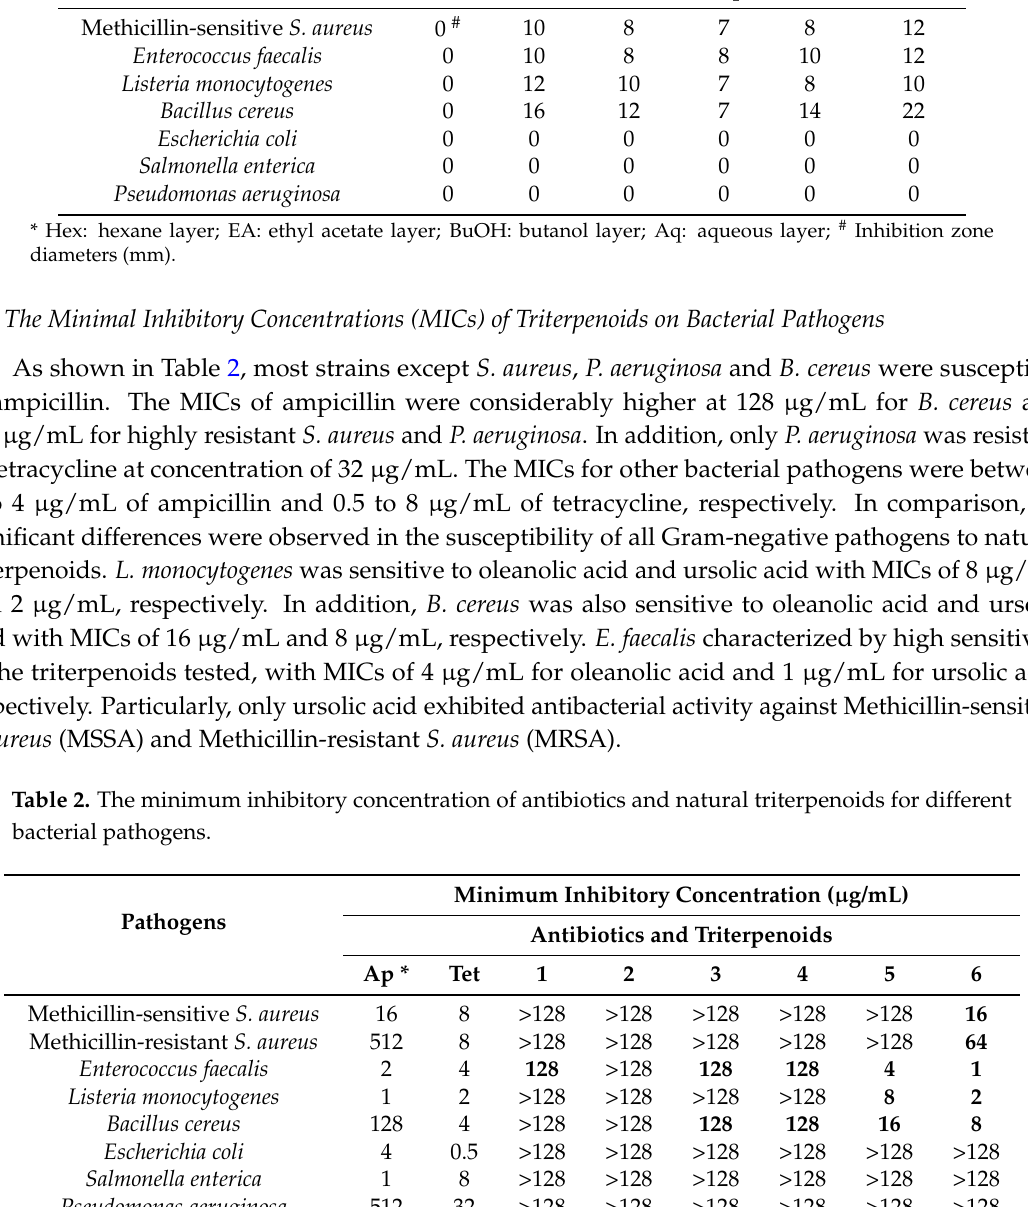
Table 1. Antibacterial activities of chemical fractions from the leaf extract of A. scholaris . Fractions Pathogens Hex * EA BuOH Aq Methicillin-sensitive S. aureus 0 # Enterococcus faecalis Listeria monocytogenes